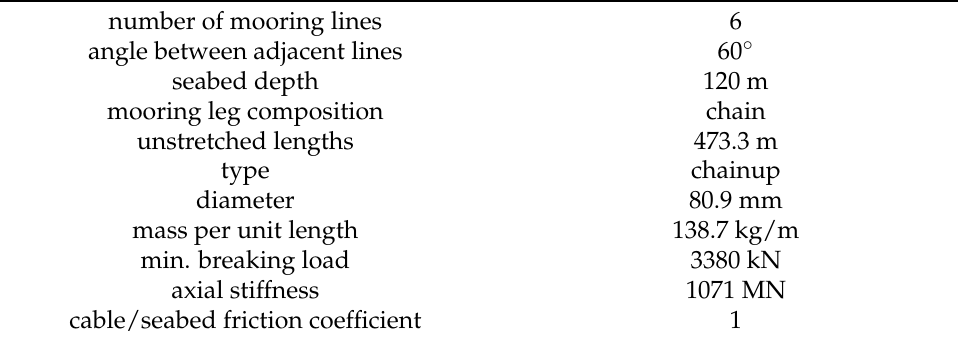
Table 2. Mooring lines